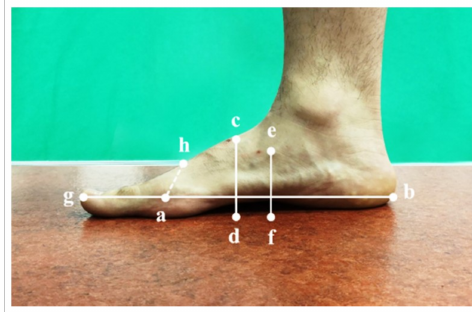
Figure 1. Schematic of foot morphological measurement. L gb : foot length; L ah : foot width; L ab : truncated foot length; L ef : navicular height; L cd : dorsum height at 50% of the foot